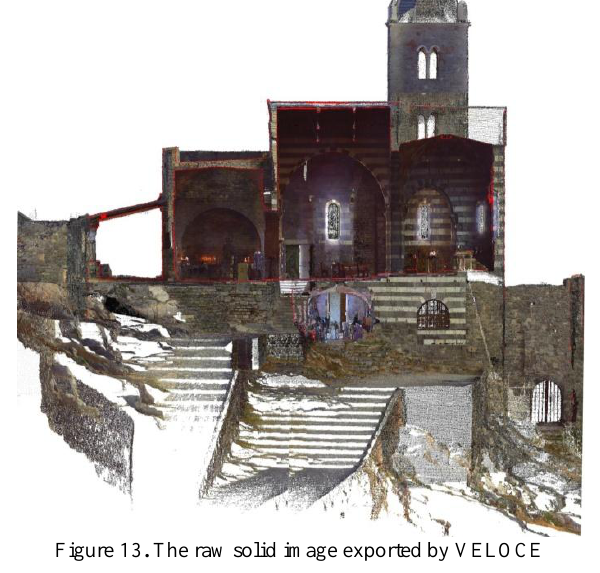
Figure 13 . The raw solid image exported by VELOCE